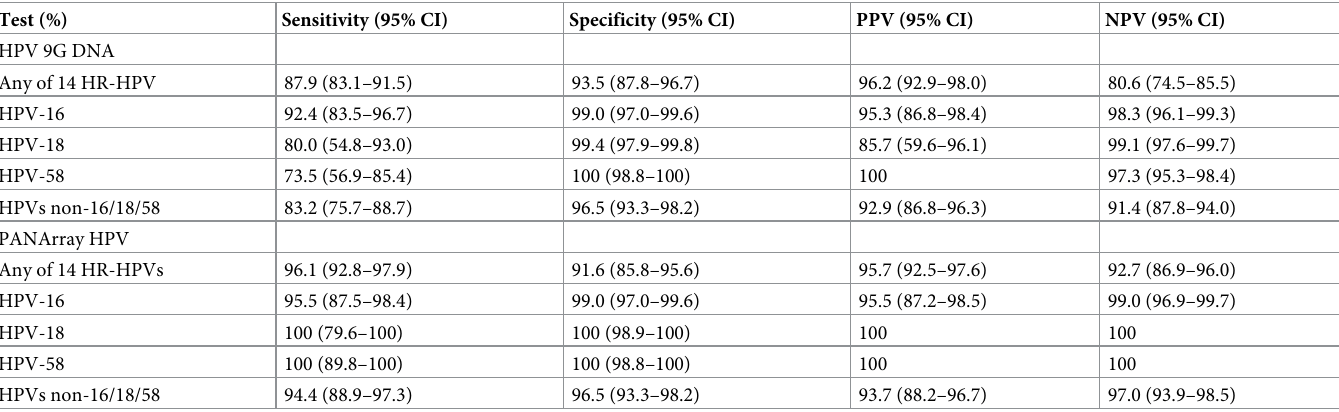
Table 4. Sensitivities and specificities of HPV chip tests for HR-HPV